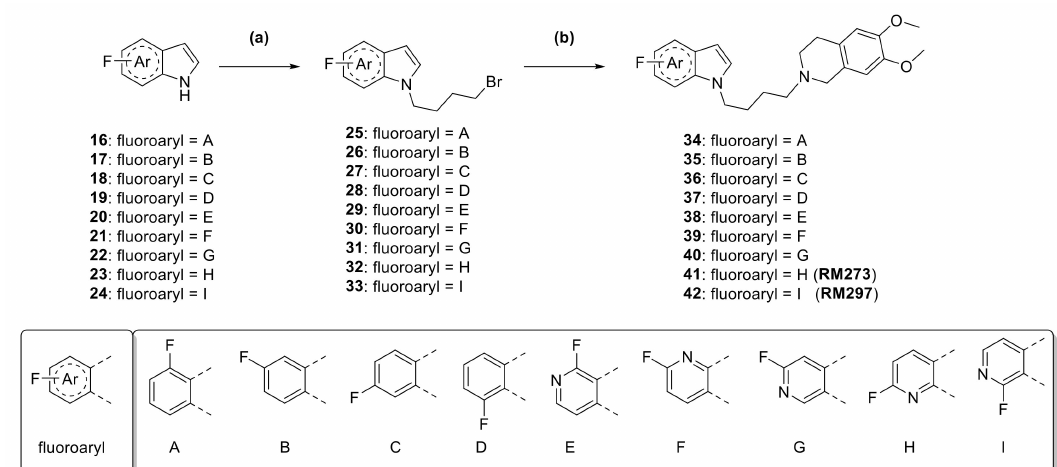
Scheme 1. Synthesis of novel fluorinated indole and azaindole derivatives 34 – 42 ; reagents and conditions: ( a ) DMF, NaH (60% dispersion in mineral oil, 1.3 eq.), Br(CH 2 ) 4 Br (10 eq.), room temperature, 6 h; ( b ) MeCN, 6,7-dimethoxy-1,2,3,4- tetrahydroisoquinoline ( 43 , 1.3 eq.), K 2 CO 3 (3 eq.), 90 ◦ C, 16 h. Abbreviations: DMF N , N -dimethylformamide; NaH sodium hydride; MeCN acetonitrile; K 2 CO 3 potassium carbonate.